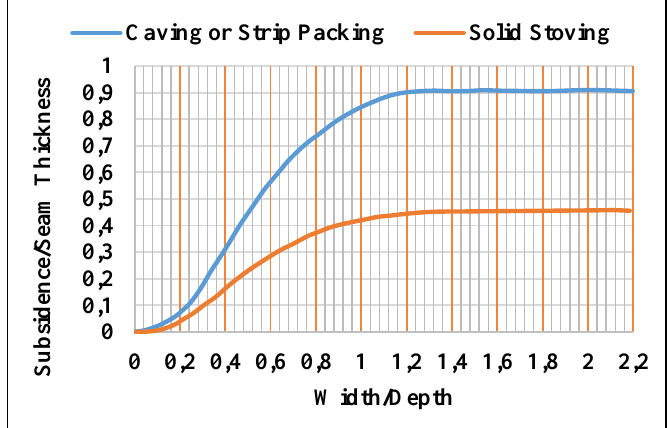
Figure 2: NCB subsidence prediction